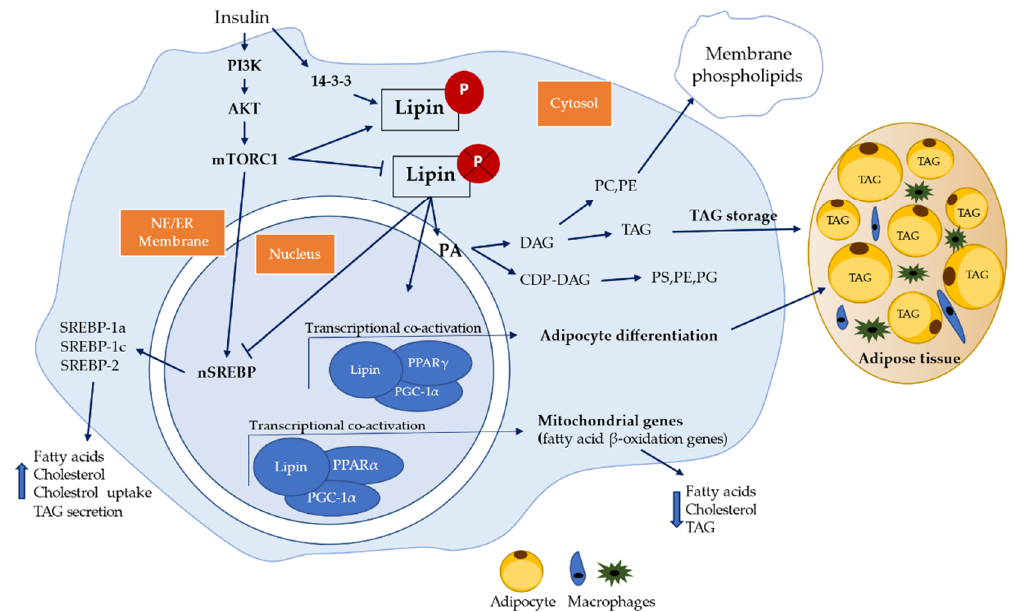
Figure 2. Schematic representations of lipin pathway and signaling. PA—phosphatidic acid; DAG—diacylglycerol; TAG—triacylglycerol; PE—phosphatidylethanolamine; PC—phosphatidylcholine; PI—phosphatidylinositol; PG—phosphatidylglycerol; CL—cardiolipin; CDP-DAG—cytidine diphosphate diacylglycerol; PS—phosphatidylserine; AKT—protein kinase B; PI3K—phosphoInositide 3-kinase; mTORC1—mitogen-activated protein kinase complex 1; nSREBP—nuclear Sterol regulatory element-binding protein; NE—nuclear envelope; ER- endoplasmic reticulum; PPAR α / γ —peroxisome proliferation-activated receptor α / γ ; PGC-1 α —peroxisome proliferator-activated receptor gamma coactivator 1-alpha [12,72,73,76].